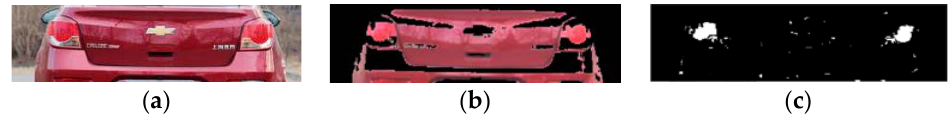
Figure 6. Results of color space conversion. ( a ) Image of vehicle in RGB space; ( b ) The segmentation result of the R channel threshold; ( c ) The segmentation result of the HSV color space.